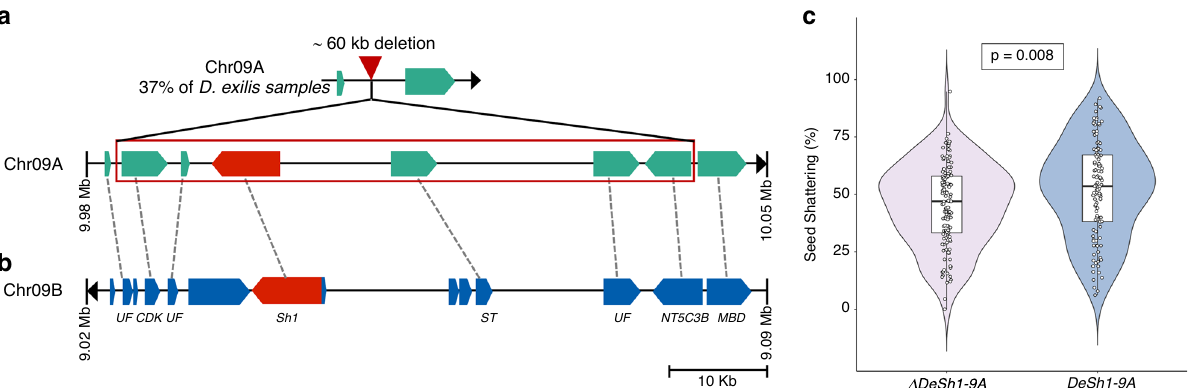
Fig. 6 Selective sweep at the Sh1 locus in fonio. a Schematic representation of genes in the orthologous regions of the sorghum Sh1 gene. The top most panel shows the region on fonio chromosome 9A with the 60 kb deletion as it is found in 37% of all D. exilis accessions. The lower panel shows the genes in accessions without the deletion. The Sh1 ortholog DeSh1-9A is shown in red. b The Sh1 ortholog DeSh1-9B on chromosome 9B is present in all D. exilis accessions. The dashed lines represent orthologous relationships between the two sub-genomes. UF protein of unknown function, CDK cyclin-dependent kinase, Sh1 ortholog of sorghum Shattering 1 ( Sh1 ), ST sulfate transporter; NT5C3B 7-methylguanosine phosphate-speci fi c 5 ’ -nucleotidase; MBD methyl- CpG-binding domain. c The violin plots show the probability distribution of the seed shattering percentage in fonio accessions carrying the DeSh1-9A deletion ( Δ DeSh1-9A ) in pink compared to accessions with an intact DeSh1-9A in blue. The shape of the distribution indicates that the seed shattering percentages for both groups are concentrated around the median. The center of each plot depicts a boxplot, the box represents the interquartile range (IQR), the middle horizontal line represents the median, the vertical lines going down and up from the box are de fi ned as fi rst quartile ( − 1.5 IQR) and third quartile ( + 1.5 IQR), respectively. Circles in the plot represent the seed shattering percentage calculated from individual fonio panicles, one circle per panicle, jitter option was added to show all individual observations that overlapped. Mean seed shattering was 45% in Δ DeSh1-9A (±0.18 s.d.) and 52% in DeSh1-9A (±0.22 s.d.). ( n = Three individual panicles of 43 Δ DeSh1-9A accessions and 39 DeSh-9A accessions, respectively; two-way ANOVA p = 0.008; df =